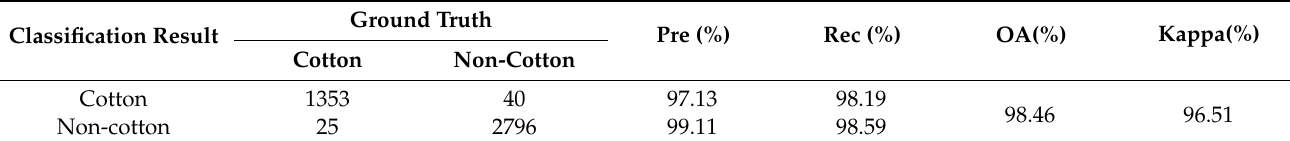
Figure 8. Spatial distribution of cotton in Xinjiang. ( b – h ) represent the case regions. The specific locations are marked in ( a ) with red boxes. Table 3. Confusion matrix of the cotton map for Xinjiang.